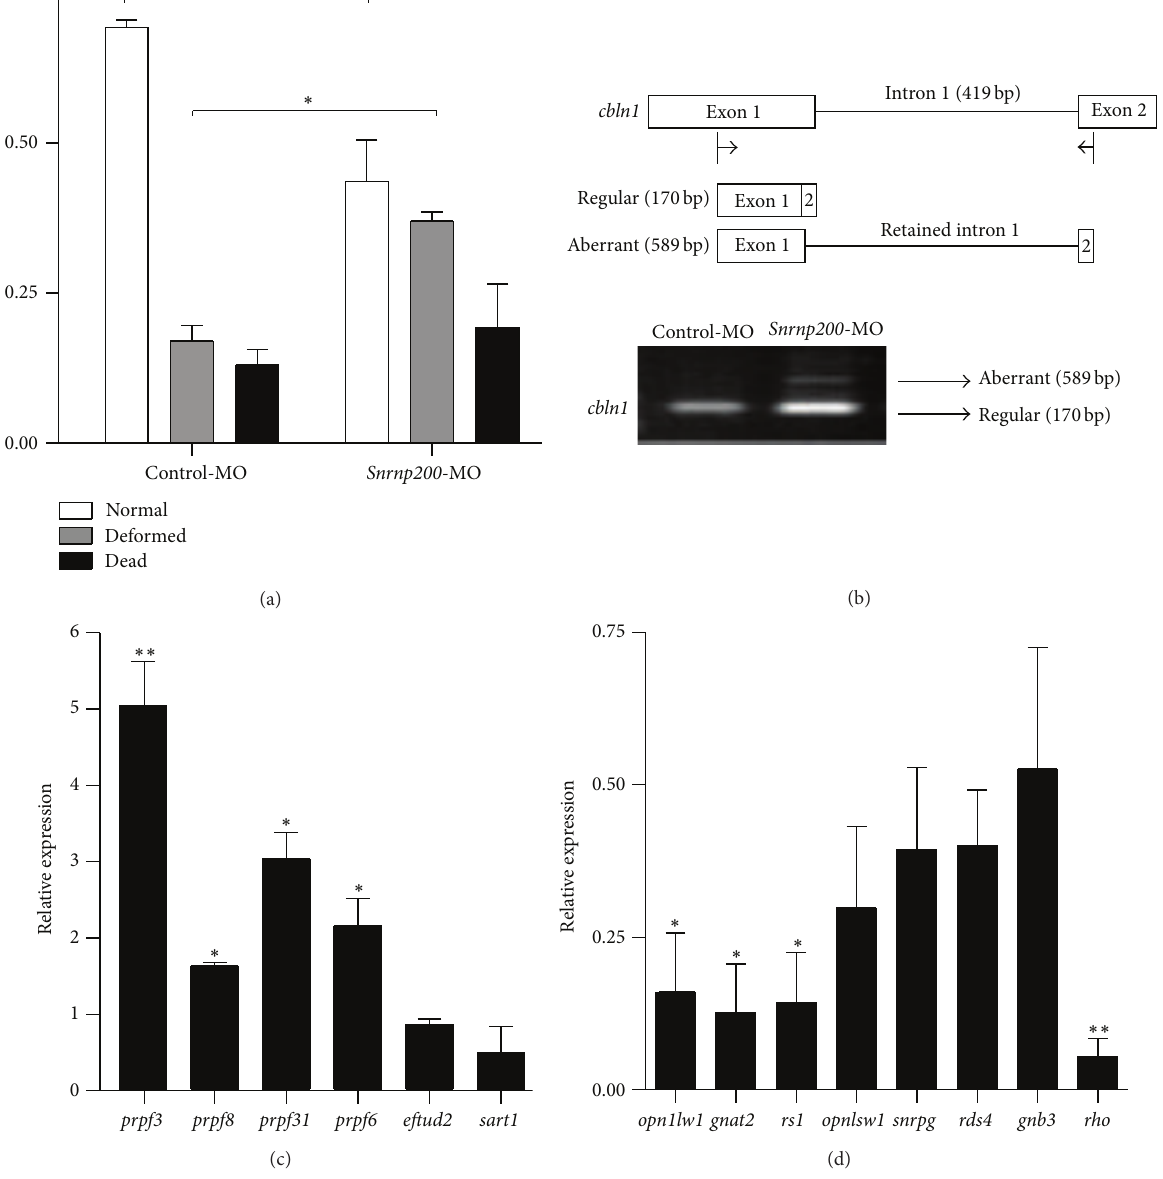
Figure 2: (a) Quantification of normal, deformed, and dead zebrafish injected with control morpholinos (control-MO) ( 𝑛 = 72 ) or Snrnp200 - MO ( 𝑛 = 68 ) from 2 to 4 days postfertilization (dpf). (b) The upper panel presents the regular and aberrant cDNA structures of the cbln1 gene, while the below panel indicates the aberrant splicing detected in the cbln1 gene in zebrafish injected with Snrnp200 -MO. The first intron of the cbln1 gene was retained. (c) The relative expressions of splicing components, including prpf3 ( 𝑃 = 0.007 ), prpf8 ( 𝑃 = 0.011 ), prpf31 ( 𝑃 = 0.032 ), prpf6 ( 𝑃 = 0.048 ), eftud2 ( 𝑃 = 0.086 ), and sartl ( 𝑃 = 0.125 ), were upregulated in zebrafish injected with Snrnp200 -MO when compared with those injected with control-MO. (d) The relative expressions of retina specific transcripts, including opn1lw1 ( 𝑃 = 0.013 ), gnat2 ( 𝑃 = 0.011 ), rs1 ( 𝑃 = 0.011 ), opnlswl ( 𝑃 = 0.060 ), snrpg ( 𝑃 = 0.068 ), rds4 ( 𝑃 = 0.056 ), gnb3 ( 𝑃 = 0.158 ), and rho ( 𝑃 = 0.002 ), were downregulated in zebrafish injected with Snrnp200 -MO when compared with those injected with control-MO. Data in (a), (c), and (d) are presented as mean ± standard deviation (SD) for technical triplicates. ∗ 𝑃 < 0.05 ; ∗∗ 𝑃 < 0.01